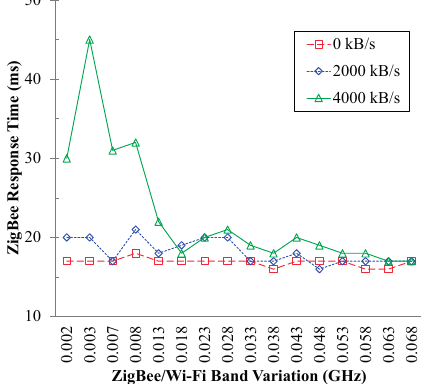
Figure 12. The impact of ZigBee/Wi-Fi band variation on the ZigBee response